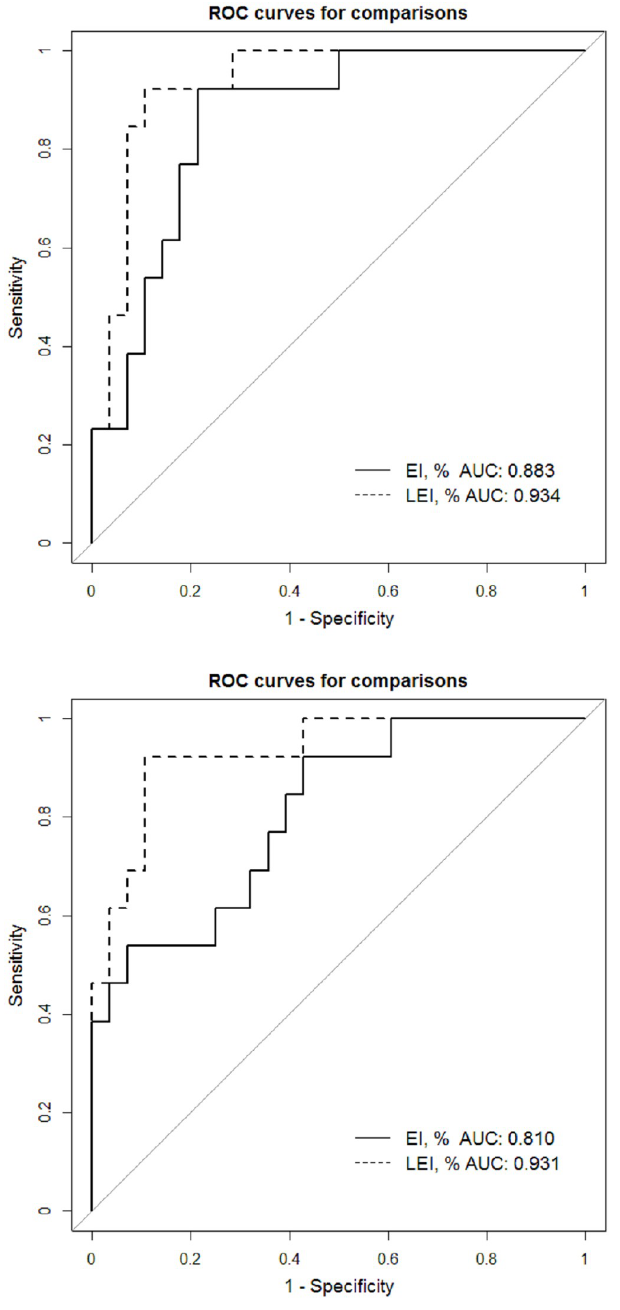
Fig 3. Receiver operating characteristic curves for comparing the emphysema index and lobe-specific emphysema index. Unadjusted analysis (A) and adjusted analysis (B).